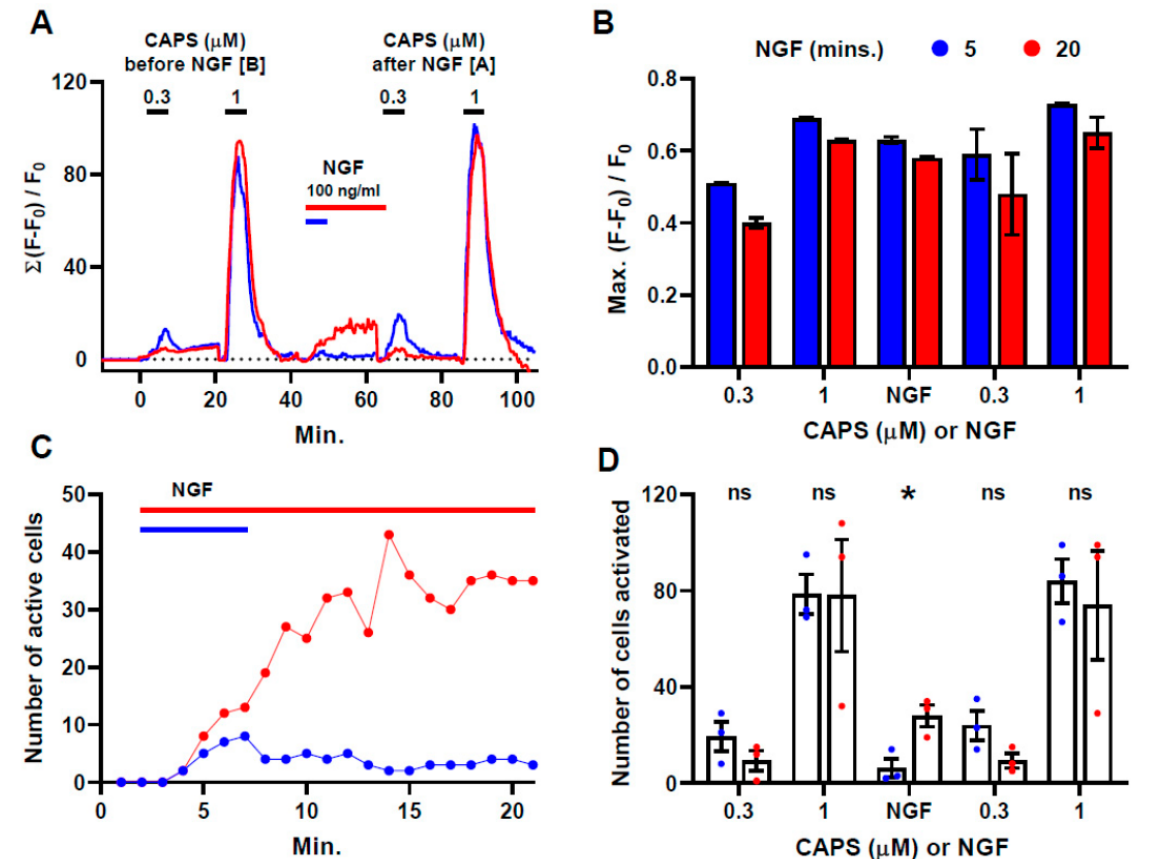
Figure 1. NGF evokes Ca2+ signals in a subset of CAPS-excitable cells. ( A ) Traces show increases in fluorescence intensity (summed from 3 experiments) in DRGNs exposed sequentially to CAPS for 5 min. (black bars, at concentrations indicated) and 100 ng/mL NGF for 5 (blue) or 20 min. (red). In the latter case, a 5 min. washout after the 20 min. exposure to NGF has been omitted from the figure to keep the subsequent responses to CAPS in register with those in the blue trace. Note that F 0 was re-zeroed (see Section 4) before each addition of CAPS or NGF. Examples of fluorescence traces from individual DRGNs are presented in Supplementary Figure S1. ( B ) Shows the mean ± s.e.m. Max. fluorescence intensity increases in neurons that responded above threshold upon exposure to each stimulus, as indicated on abscissa, in DRG exposed to NGF for 5 (blue bars) or 20 min. (red bars). Significant differences were observed for 0.3 µ M CAPS before NGF ( p = 0.03), reflecting minor variation between experimental groups, and for 1 µ M CAPS after NGF ( p = 0.02) but this latter difference might be due to the high background fluorescence after 20 min. with NGF, which may interfere with the quantification of subsequent responses to CAPS. ( C ) Number of active cells counted in 1 min. intervals after the addition of NGF, plotted against time; data summed from 3 independent recordings for each NGF treatment. ( D ) Mean number of cells activated ( ± s.e.m., N = 3) over 20 min. after the addition of CAPS (at concentrations indicated), or NGF, in DRG exposed to the latter for 5 (blue) or 20 min. (red). Results obtained with either CAPS concentration are shown for a two-tailed Student’s t -test between groups exposed to NGF for 5 min. and those treated for 20 min; * p < 0.05; ns, not significant. Full statistical analysis is detailed in the Supplementary Table